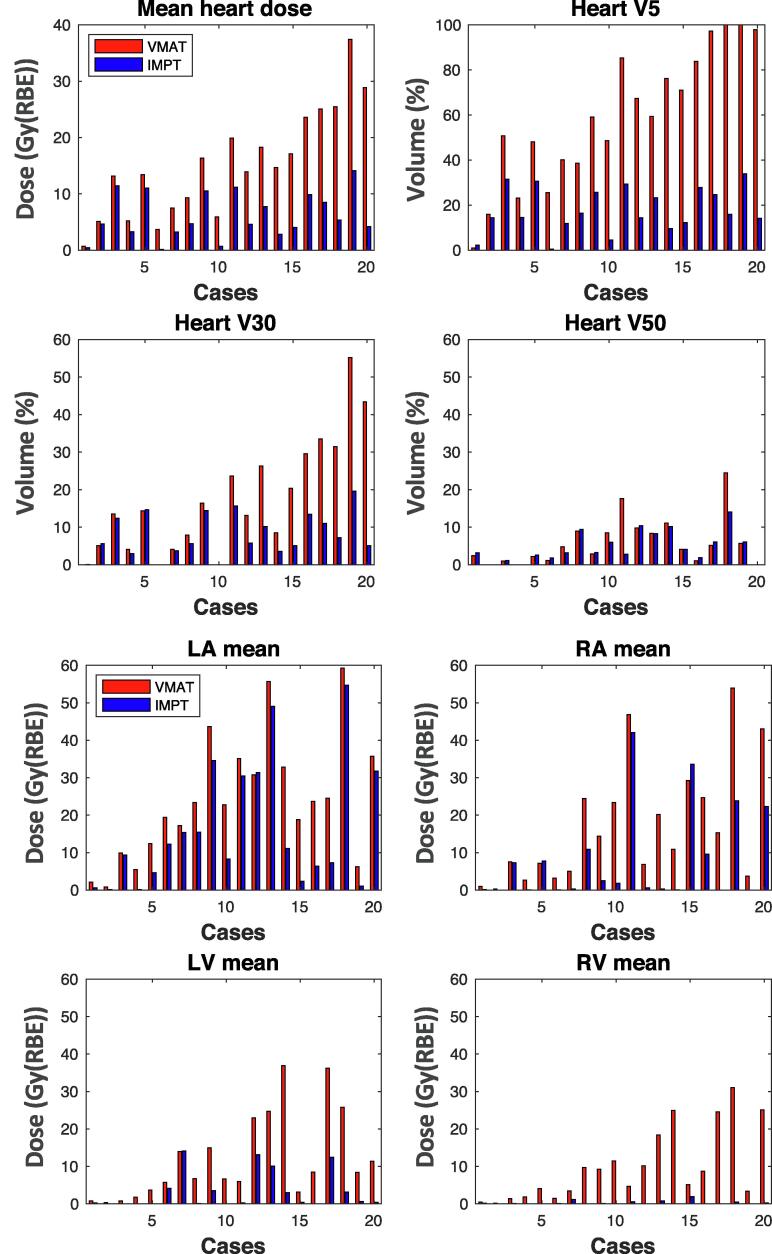
Absolute dose to the heart and substructures.